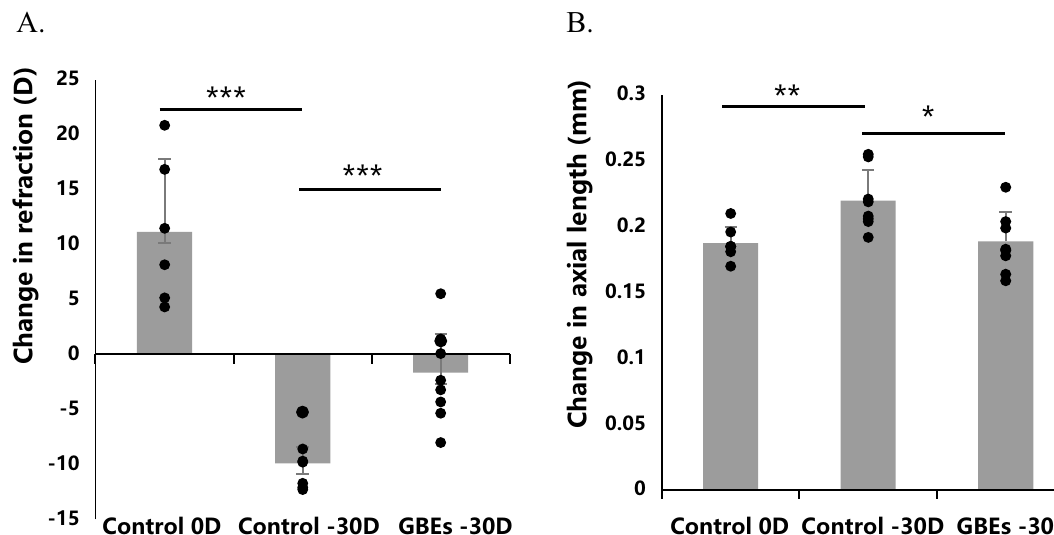
Figure 2. GBEs significantly suppressed a myopic refractive shift and axial elongation in a murine LIM model. ( A ). In the control 0 D and − 30 D groups, the eyes treated with − 30 D lenses had a significantly greater refractive shift than the eyes treated with 0 D lenses ( p < 0.001). When compared to the control − 30 D group, mice in the GBEs − 30 D group showed a significantly reduced refractive shift ( p < 0.001) (n = 8). ( B ). Compared to the control 0 D group, the control − 30 D group showed a significant axial elongation ( p < 0.01). Compared to the control − 30 D group, the GBEs − 30 D group showed a significantly smaller axial elongation ( p < 0.05) (n = 8). * p < 0.05, ** p < 0.01, *** p < 0.001, bars represent mean + / − standard deviations. The one-way ANOVA was used to determine significant